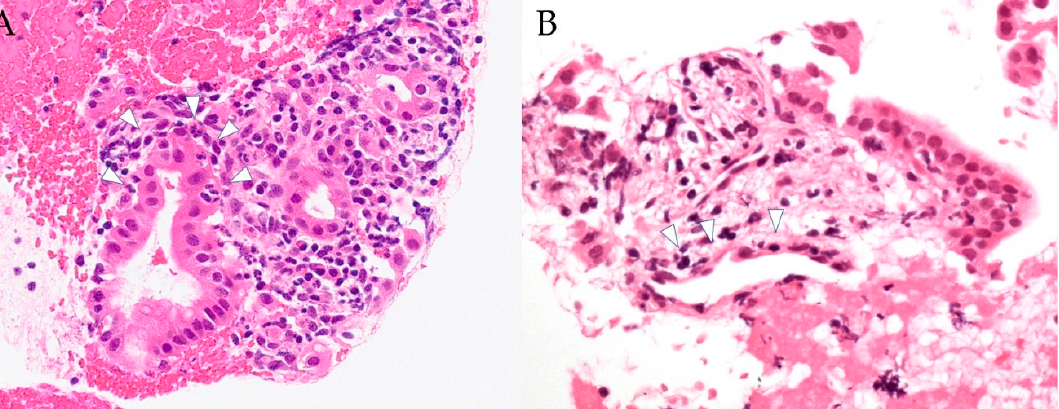
Figure 2. Histopathological tissue obtained using EUS-FNB from a patient with a confirmed diagnosis of type 2 autoimmune pancreatitis. ( A , B ) Histological examination of specimens showing GELs (arrowhead, hematoxylin–eosin stain, ×